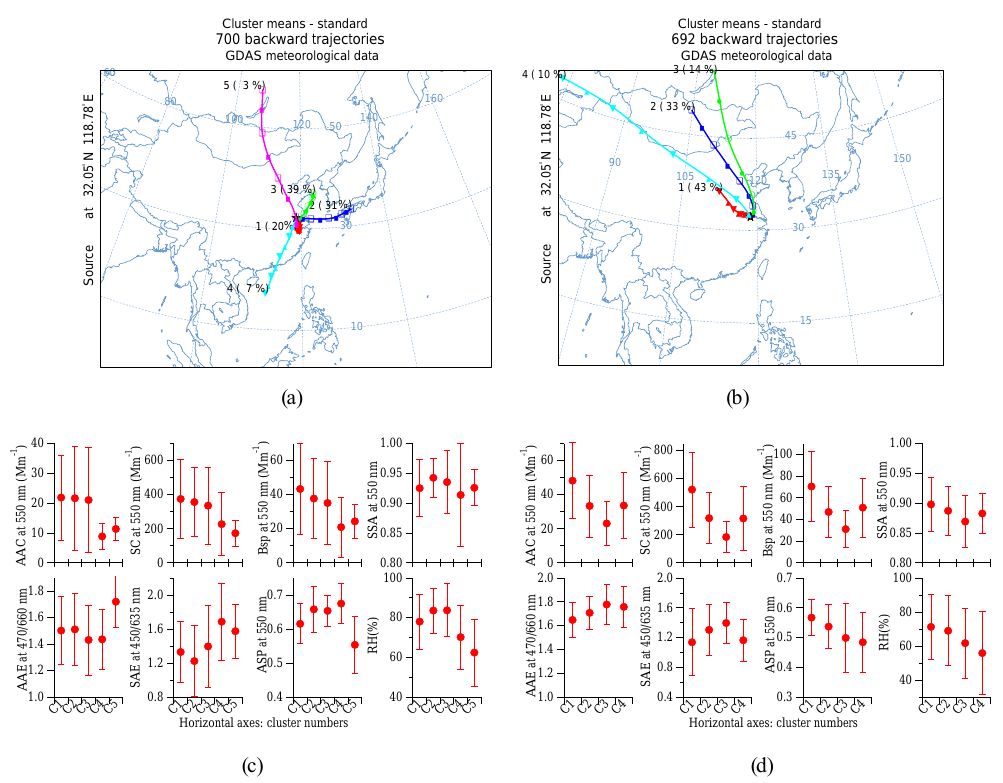
Figure 5. Clusters of 96h back trajectories arriving at the study site at 100m in JJA (a) and DJF (b) simulated by the HYSPLIT model. The means with standard deviations of the aerosol optical properties at each cluster of back trajectories in both JJA and DJF are plotted in (c) and (d)